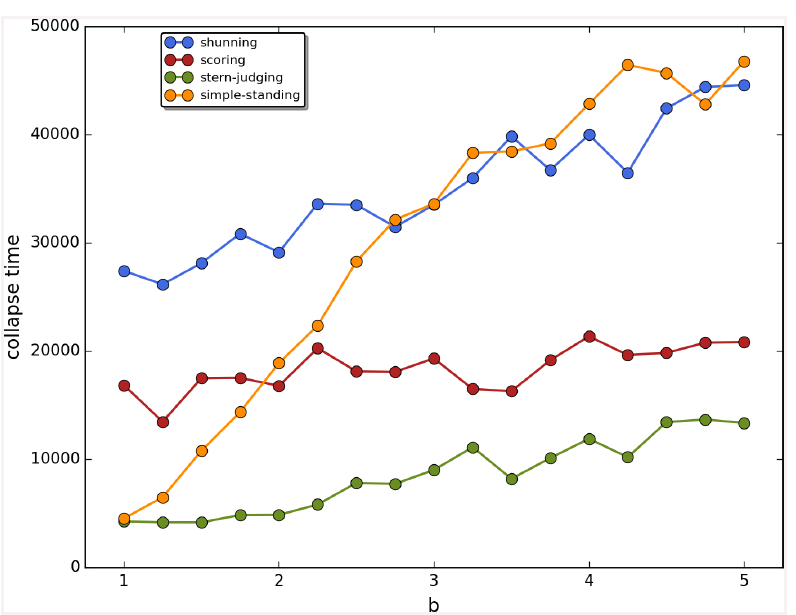
Fig 4. The average time elapsed till the collapse of cooperation, MST80. The figure shows the average time until the collapse of cooperation as a function of the value of the benefit ( b ) for different social norms in the first scenario (MST80). Each symbol represents the average of 100 runs, parameters are as follows: n = 100, c = 1, α = 1, β = 4, MST =